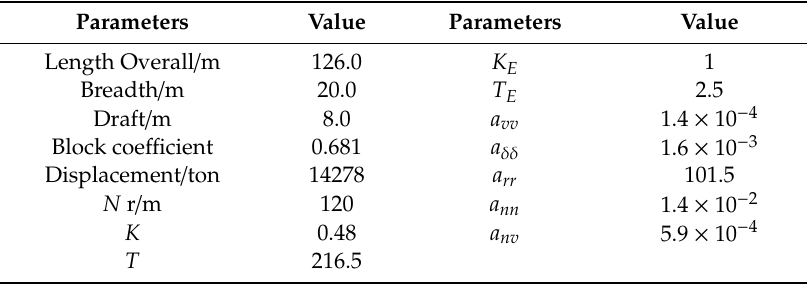
Table 4. Principal particulars and manoeuvrability characteristics of ship A.